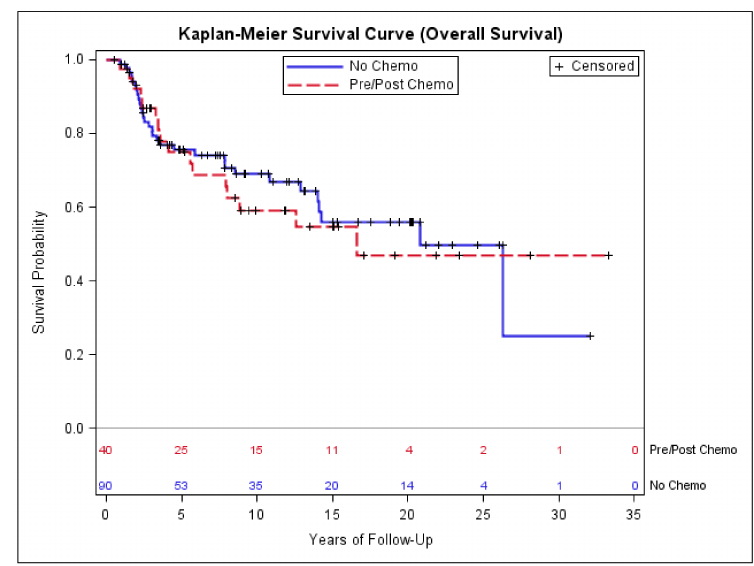
Figure 5. Kaplan–Meier estimates of overall survival of early-stage patients who did and did not receive